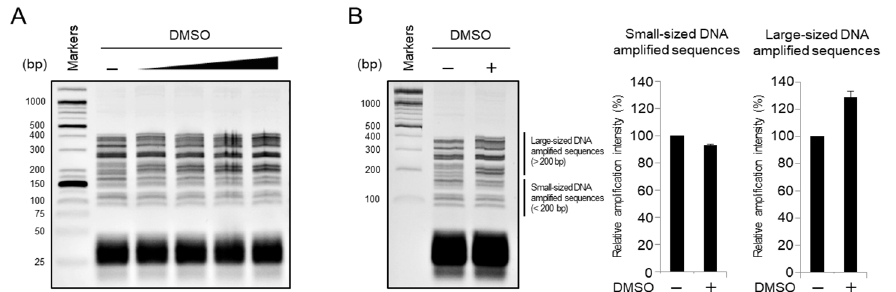
Figure 1. Effect of dimethyl sulfoxide (DMSO) on multiplex PCR amplification kit. ( A ) Amplification of 2800M DNA (2 µ g) with dose-dependent concentrations of DMSO (0, 1, 2.5, 3.75, and 5%, v / v ) using the GlobalFiler Kit. ( B ) Amplification of 2800M DNA (2 µ g) with appropriate concentration of DMSO (3.75%, v / v ) using the GlobalFiler kit. Amplification yield of 2800M DNA was compared in each of small- and large-sized DNA amplified sequences. Intensity of amplified PCR product was measured by Image J software.